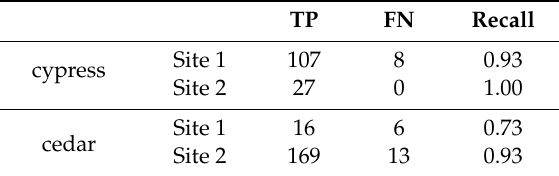
Table 4. Tree detection rate on both sites.